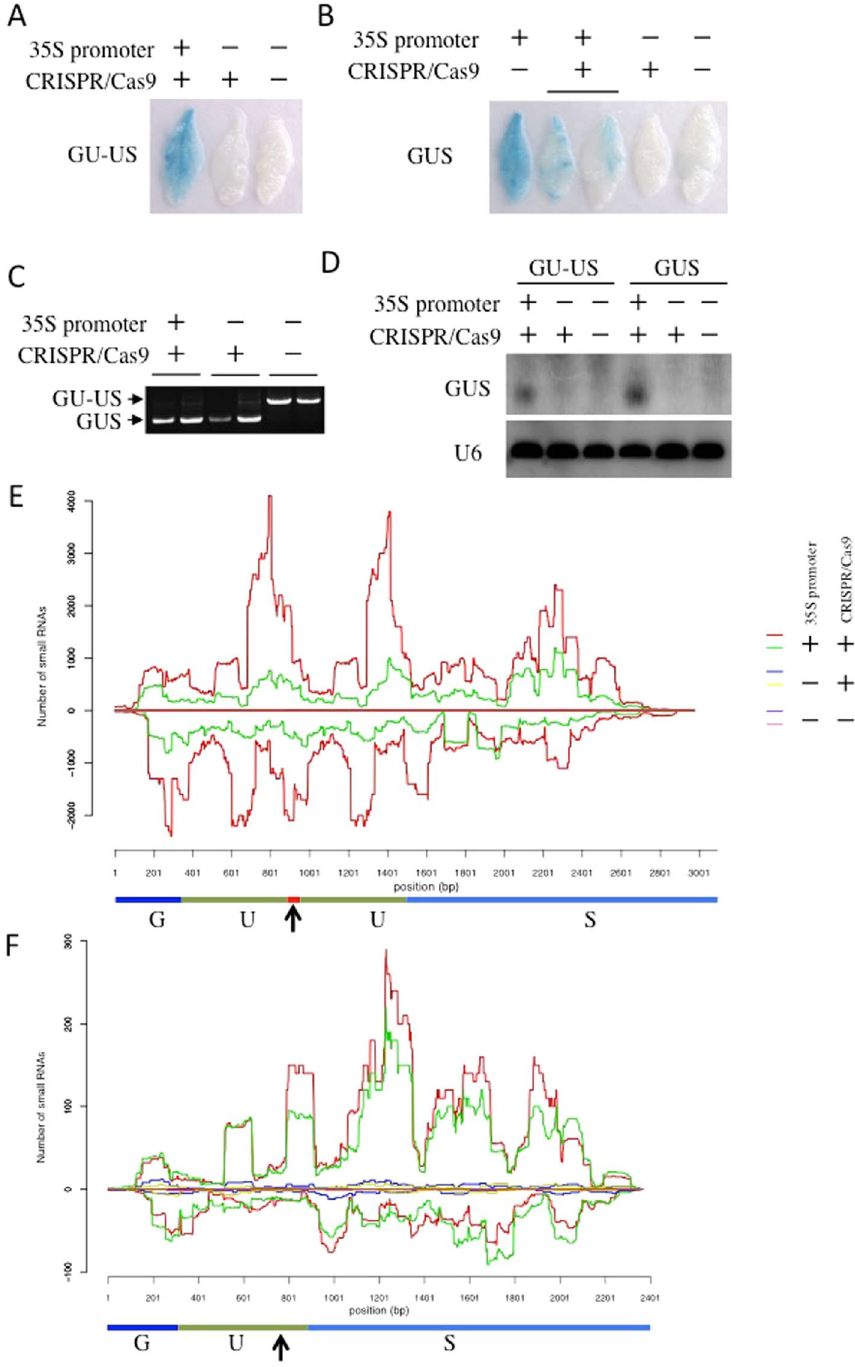
Figure 4. Efficient diRNA production requires active transcription. ( A ) Representative GUS staining images of GU-US reporter system in T1. ( B ) Representative GUS staining images of functional GUS targeted by CRIPSR/ Cas9 in T1. ( C ) Detection of GU-US transgene repair by PCR. The longer fragment indicates the parental (unrepaired) GU-US, and the shorter fragment indicates the functional GUS generated by HR. The PCR product size of GU-US and GUS are 1446 bp and 888 bp, respectively. Electrophoresis gel image was cropped nearby signals. ( D ) Detection of small RNAs by Northern blot. The U of GUS gene was as a probe. U6 was probed as control. Northern blotting image was cropped nearby signals. ( E ) The distribution of small RNAs around the GU-US transgene, under the indicated conditions. Two independent T1 transgenic lines for each construct were analyzed. ( F ) The distribution of small RNA for GUS transgene, under the indicated conditions. Two independent T1 transgenic lines for each construct were analyzed. ( E , F ) The y axis represents the number of small RNA reads within 100 bp sliding windows with a step size of 1 bp, numbers in ( + ) and ( − ) values represent the reads of 21 nt in length small RNAs derived from sense and antisense strands, respectively. The vertical arrows indicate CRISPR/ Cas9 target sites. ( A – F ) 35S promoter and CRIPSR/Cas9 genotype were indicated as with ( + ) or without ( −